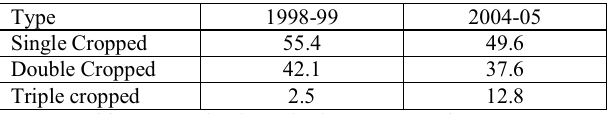
Table 5: Cropping intensity in 1998-99 and